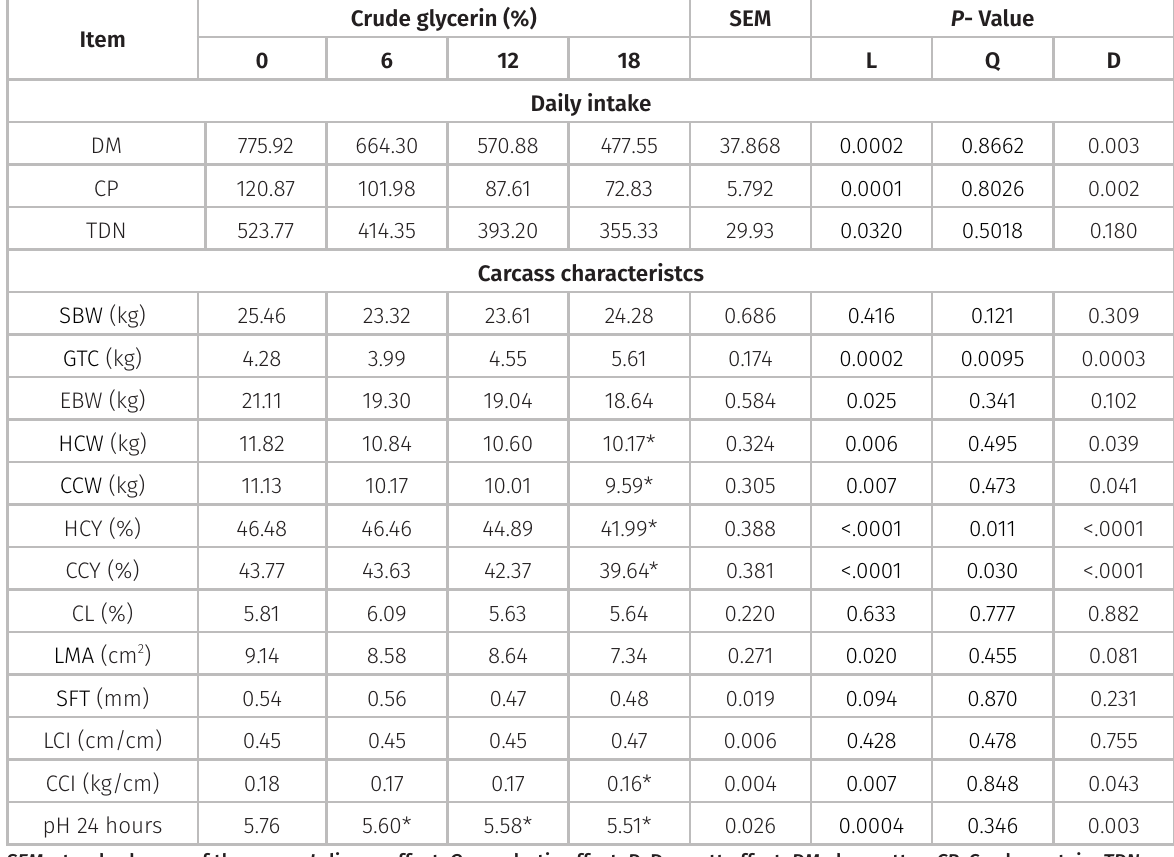
Table II. Nutrients intake and carcass characteristics of goats fed diets containing increasing levels of crude glycerin containing 63.06% glycerol and 45.57%